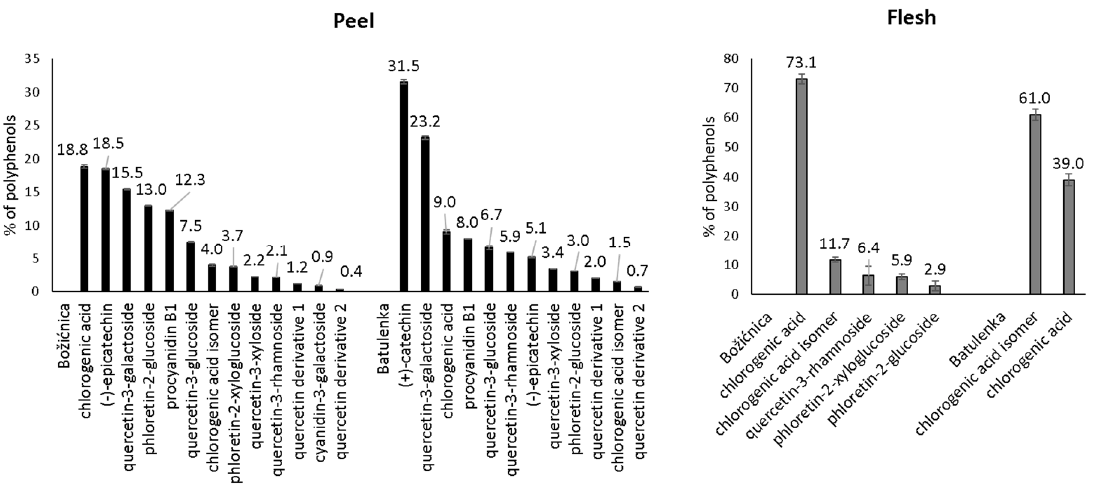
Figure 1. Percentage distribution of individual polyphenols in purified polyphenol extracts before adsorption ( n = 3).